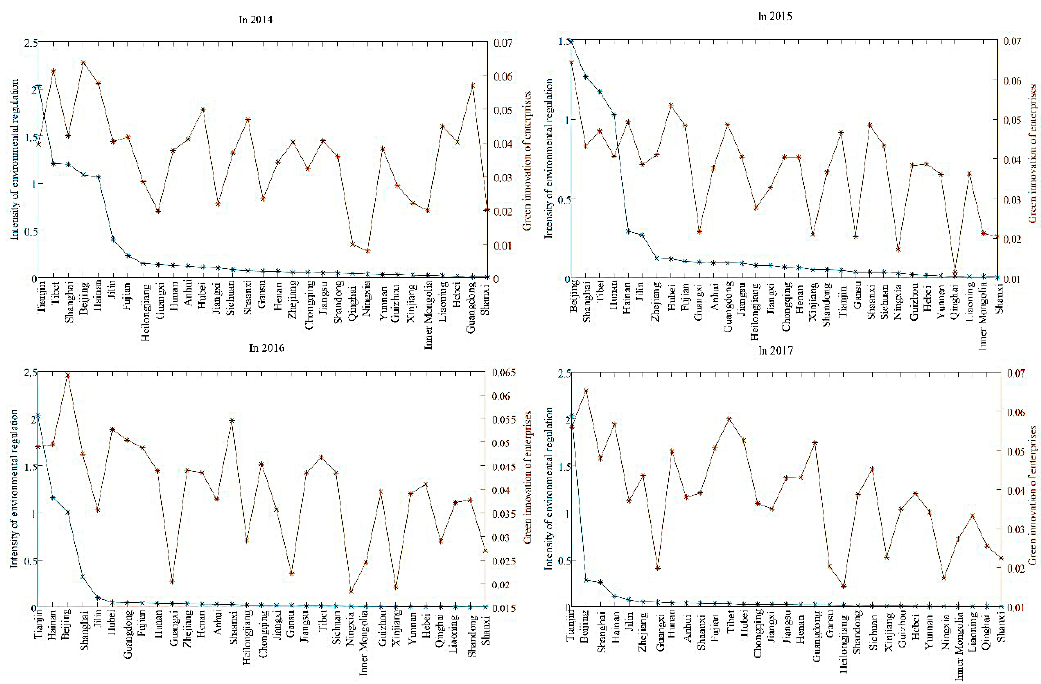
Figure 2. The environmental regulations and green innovation of enterprises in China in 2014–2017.